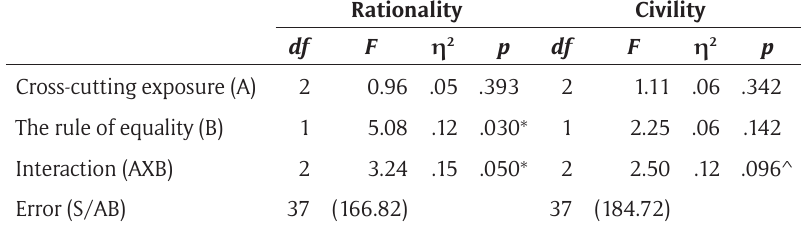
Table 3: Effects of cross-cutting exposure and the rule of equality on the deliberativeness of abortion